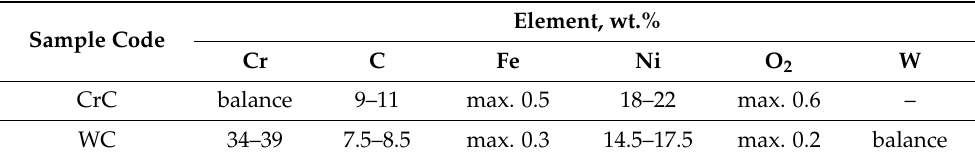
Table 1. The chemical composition of the WC–CrC–Ni (WC) and and Cr 3 C 2 –NiCr (CrC) cermet powders [15].